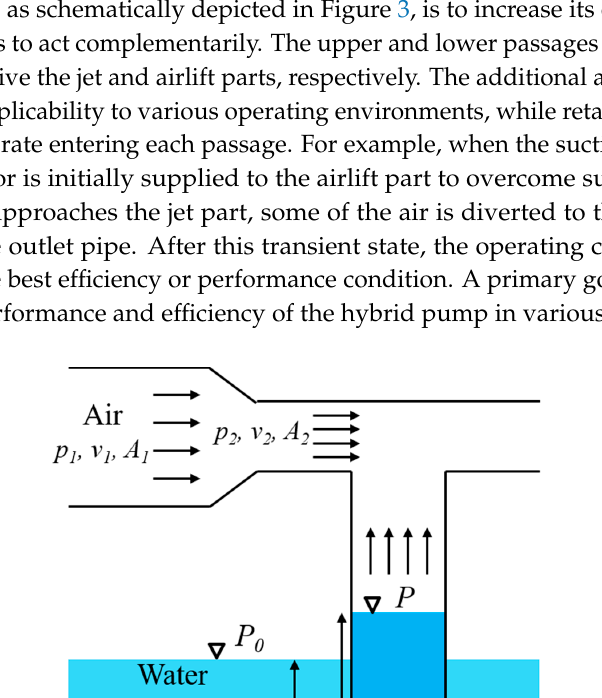
Figure 2. Schematics of an airlift pump.